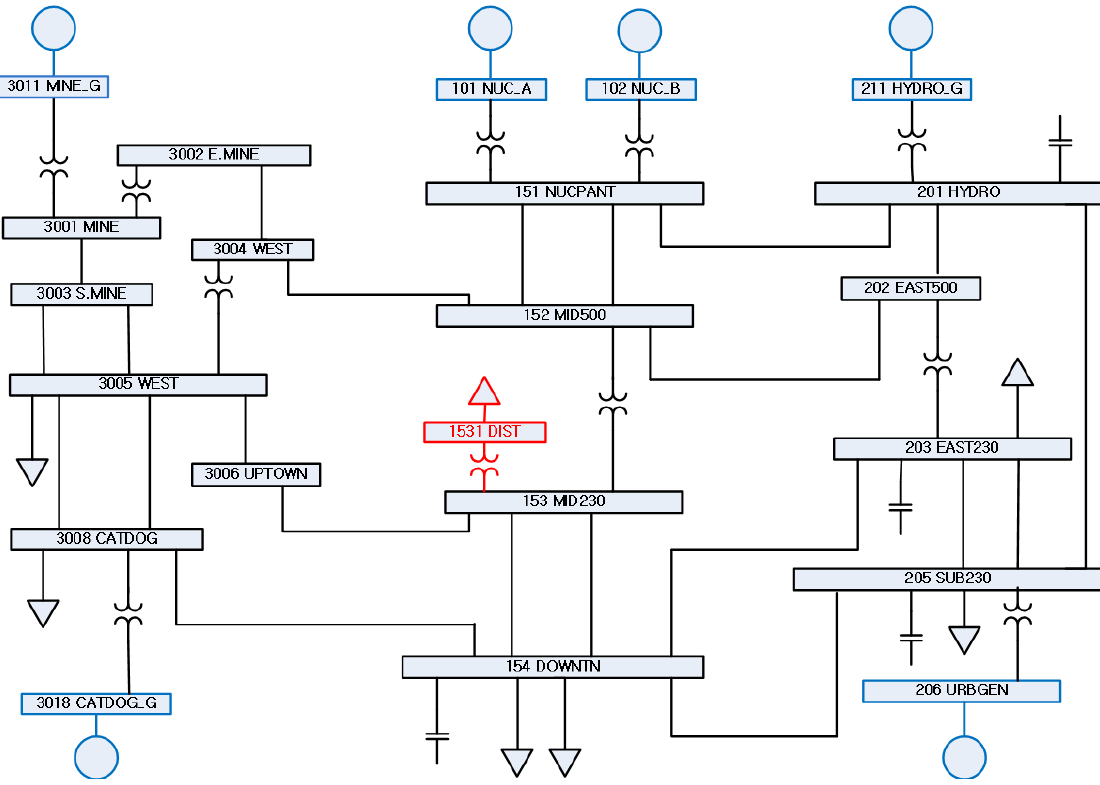
Figure 1. Test power system.